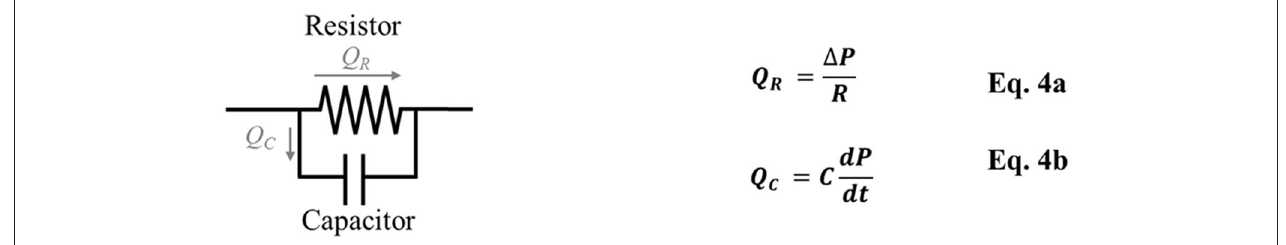
FIGURE 1 | Windkessel model/Lumped-parameter modeling consists of a resistor, which represents vascular resistance (R), and a capacitor, which represents vascular compliance (C). Q R is the blood flow through the resistor, Q C is the blood flow through the capacitor, 1 P is the pressure difference, dP/dt is the pressure change over